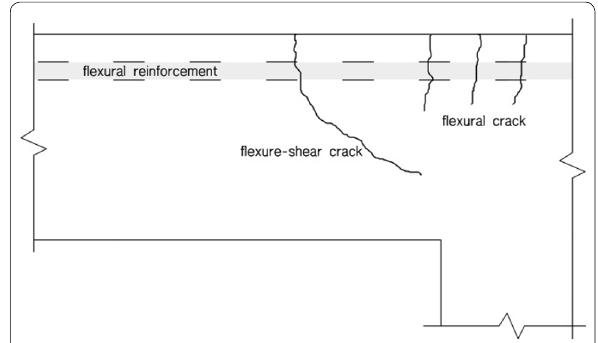
Fig. 8 Diagonal tension crack.